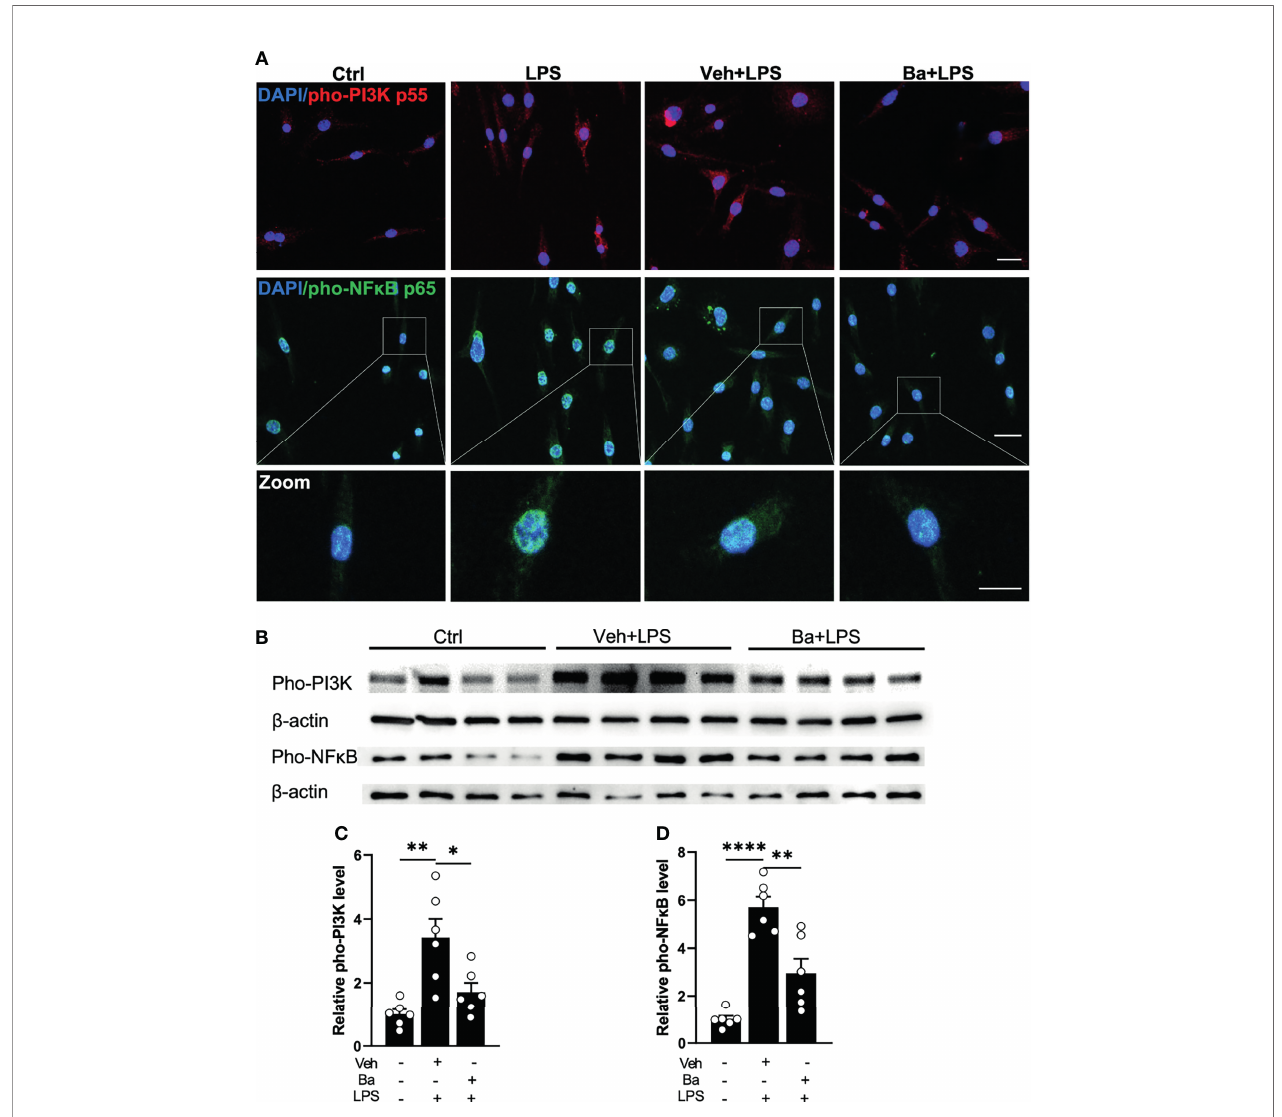
FIGURE 2 | Baicalein inhibits LPS-induced phosphorylation of PI3K/NF k B axis in microglia. (A) Representative immuno fl uorescence photomicrographs showing pho-PI3K p55 (red), pho-NF k B p65 (green), and nuclear labeling with DAPI (blue) on BV2 microglial cells that were untreated (Ctrl) or pretreated with vehicle (Veh) or 10 m M baicalein (Ba) for 24 h followed by 3 h LPS stimulation. Insets showing enlarged images of cells with pho-NF k B and DAPI labeling. Scale bar = 20 m m; 10 m m (insert). (B) Western blots showing the expression of pho-PI3K p55 and pho-NF k B p65 and b -actin (loading control) in BV2 cells that were untreated (Ctrl) or pretreated with Veh or Ba for 24 h followed by 3 h LPS stimulation. (C, D) Relative densitometer analysis of Western blots for pho-PI3K (C) and pho-NF k B (D) normalized to b -actin independently in BV2 cells. N = 6 per group. Data were presented as mean ± SEM. Each dot represented individual replicate. * P < 0.05, ** P < 0.01, **** P < 0.0001, one-way ANOVA with Tukey ’ s multiple comparisons